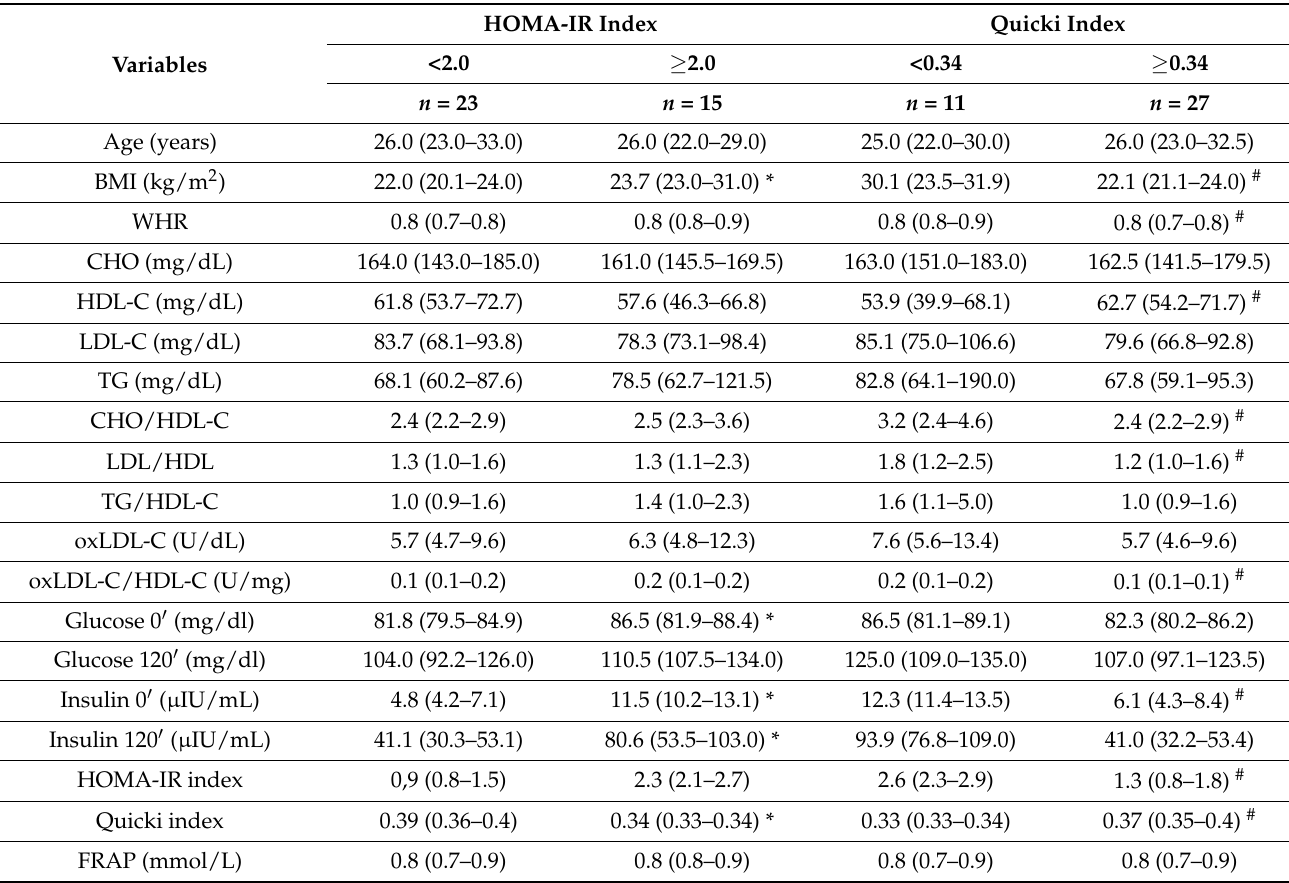
Table 2. Examined parameters in PCOS women divided according to HOMA-IR and Quicki value.